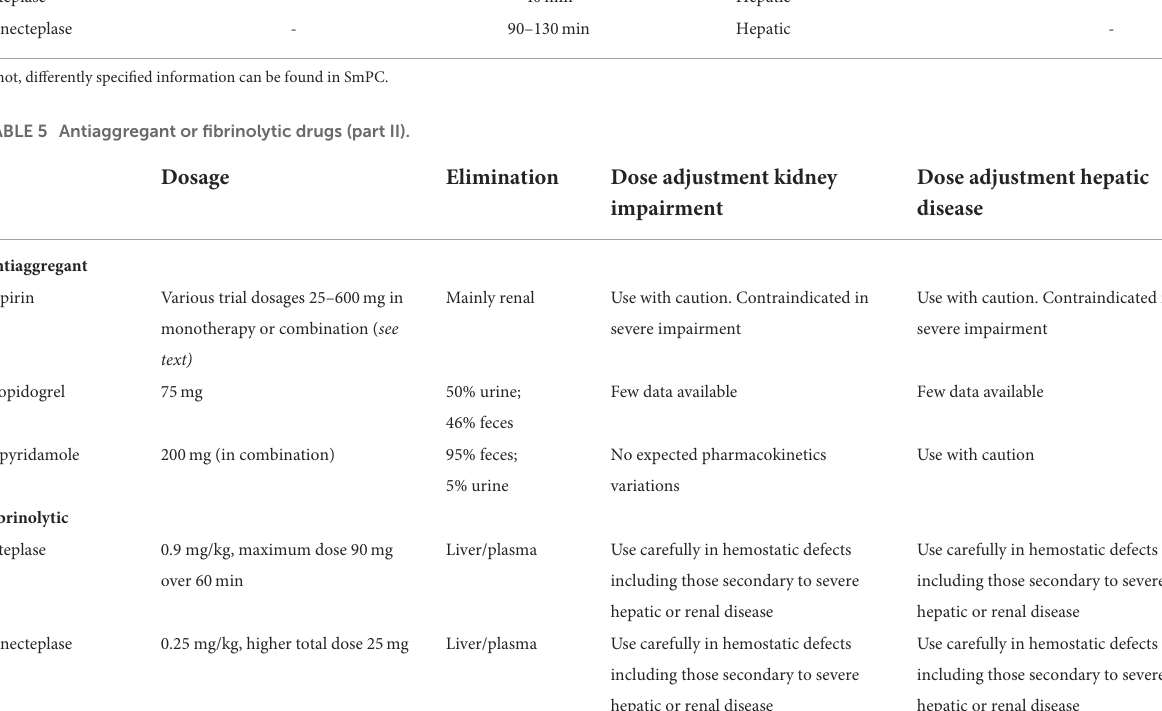
TABLE 5 Antiaggregant or fibrinolytic drugs (part